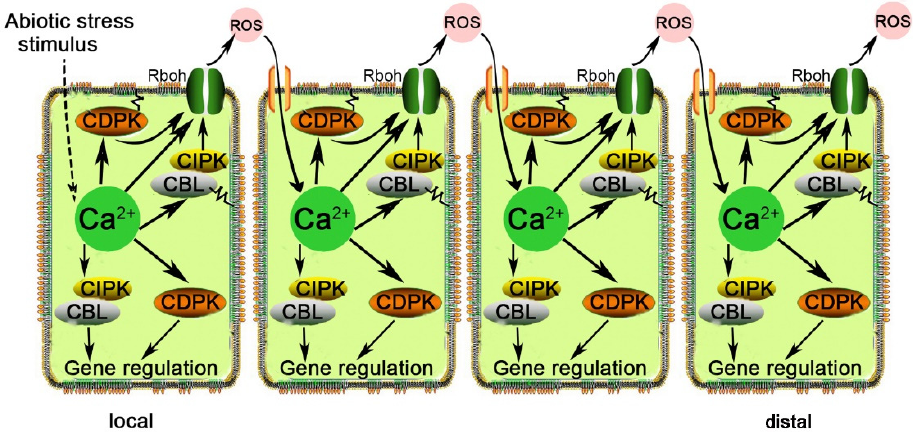
Figure 3. Schematic model of Ca 2+ - and ROS-mediated cell-to-cell signal propagation over long distances in plants. Stimulating the production of cytosolic Ca 2+ signals results in the activation of RBOHD by Ca 2+ -regulated kinases, which produce ROS and then propagate the signal by activating Ca 2+ channels in neighboring